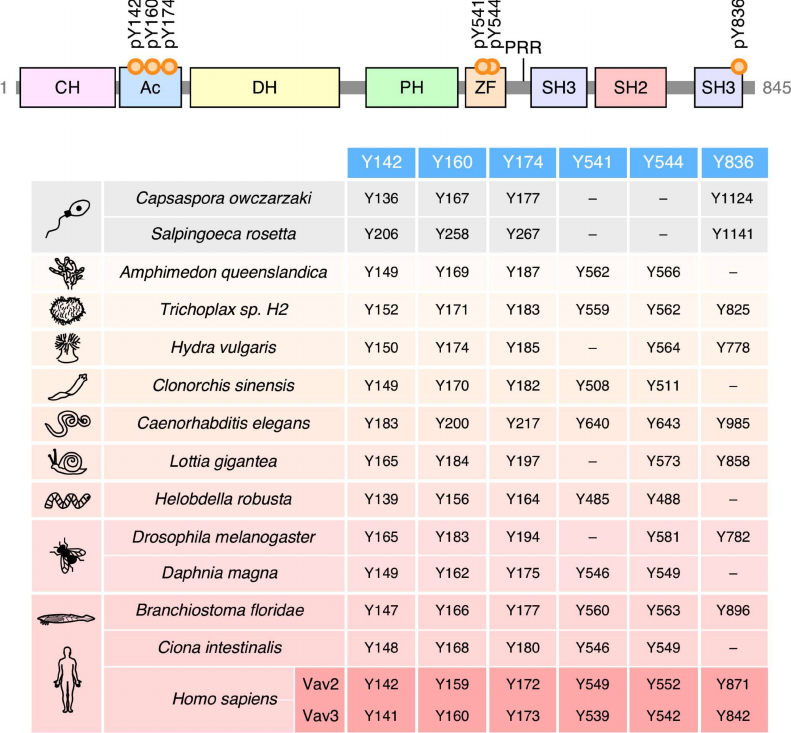
Figure 4. Conservation of the main phosphosites involved in Vav family regulation.For comparison, we include the structure and positions of the regulatory phosphosites of mouse Vav1 (top). Numbers (red boxes) indicate the position in the primary sequence of the indicated Vav family protein of the regulatory phosphosites that were previously identified in mammalian Vav1 (blue